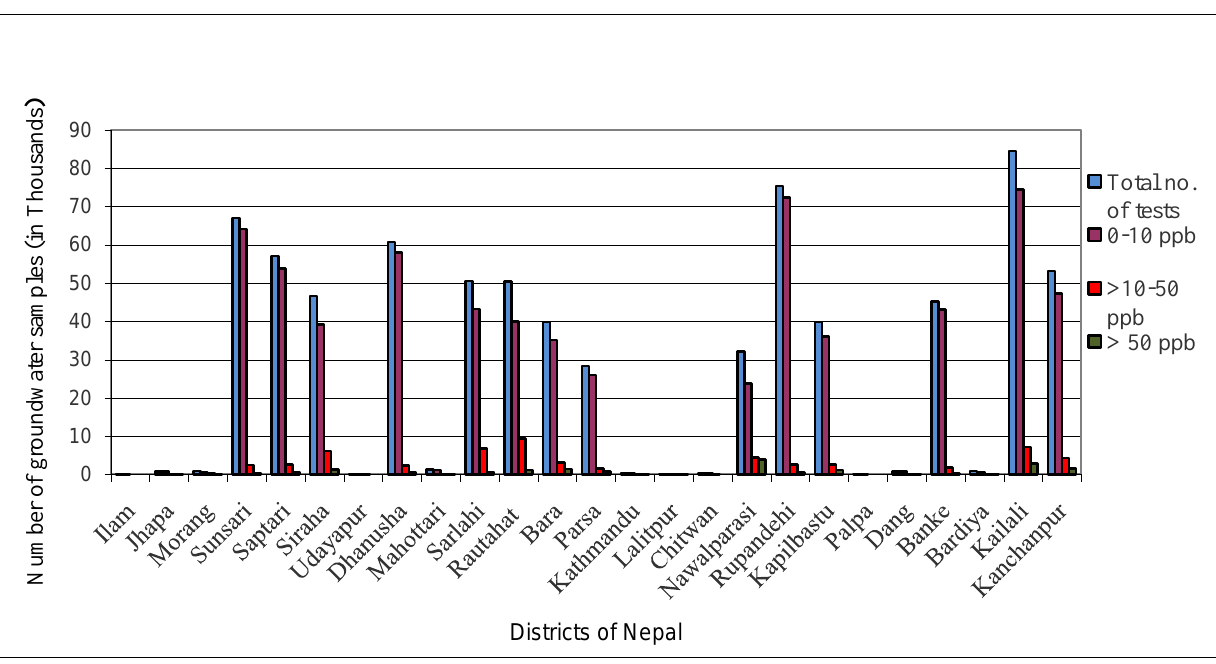
Figure 4. Arsenic (total) concentration in the samples of groundwater of different districts in